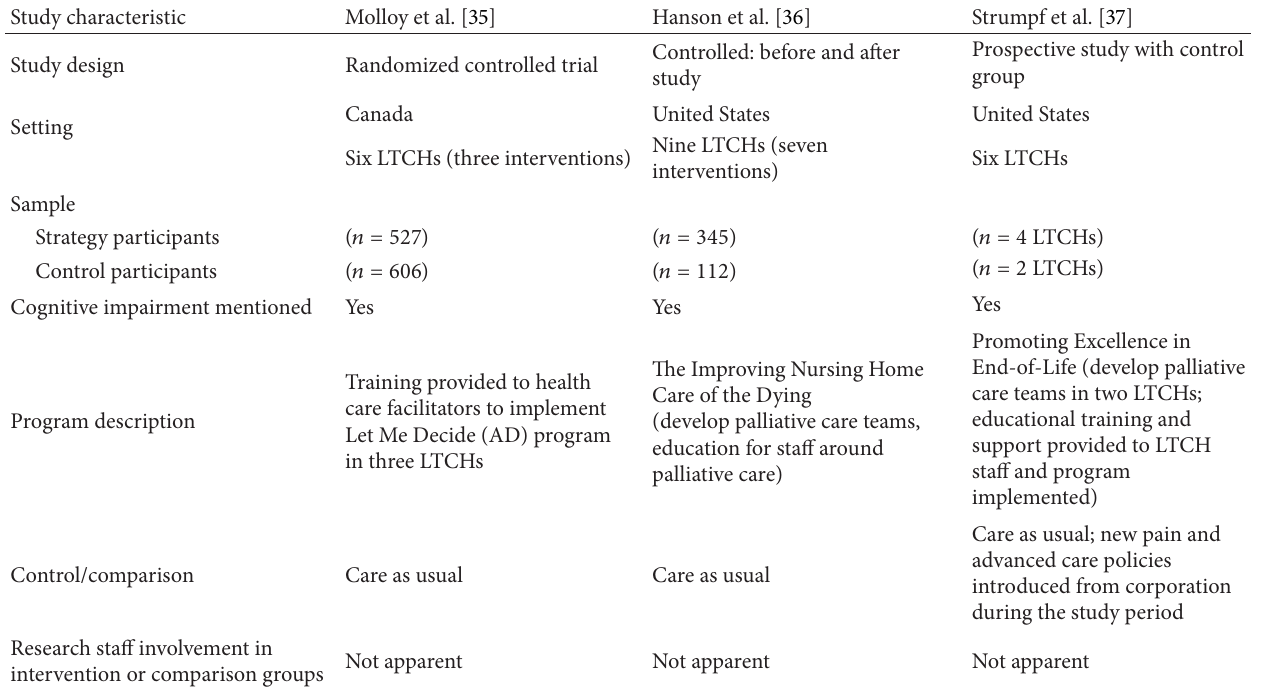
Table 2: Characteristics of the evaluated